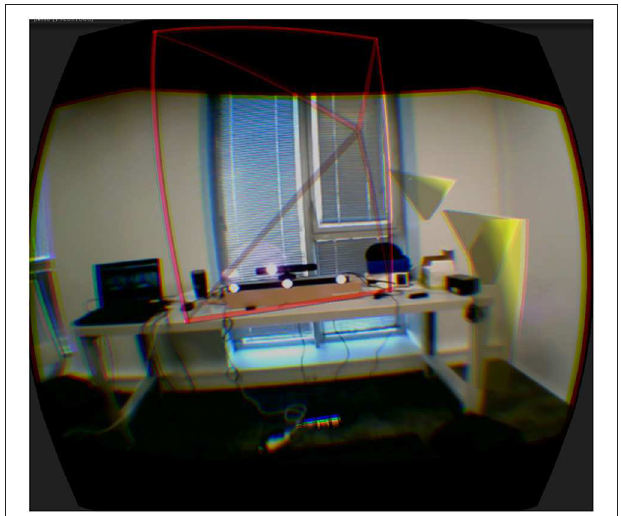
FIGURE 8 | A simple guiding technique based on the viewing frustum of the remote expert and a continuous path made up of directional arrows. This aims to mimic the guiding arms technique, especially in the case where the expert’s frustum is not visible from the current operator’s